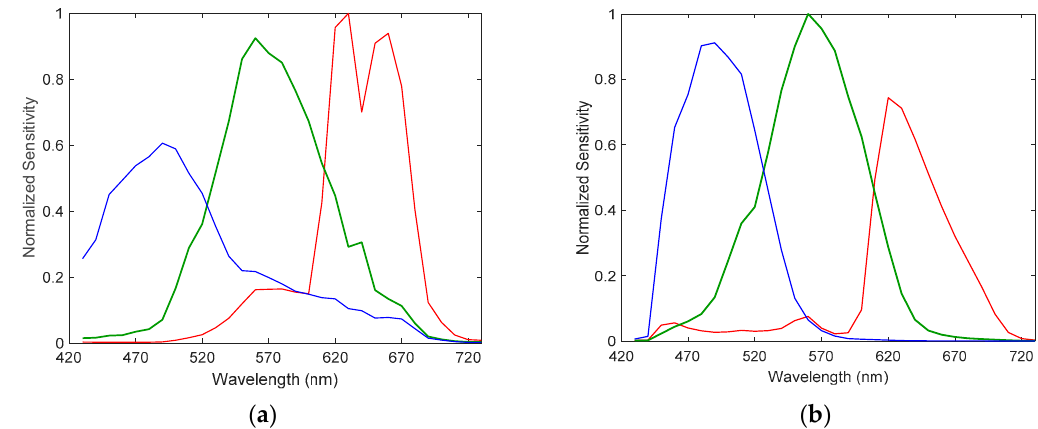
Figure 3. RGB camera sensitivity for RGB image reconstruction: camera sensitivity for ( a ) a Nokia N900 and ( b ) a Nikon D700. Table 2. Results for the Harvard database.